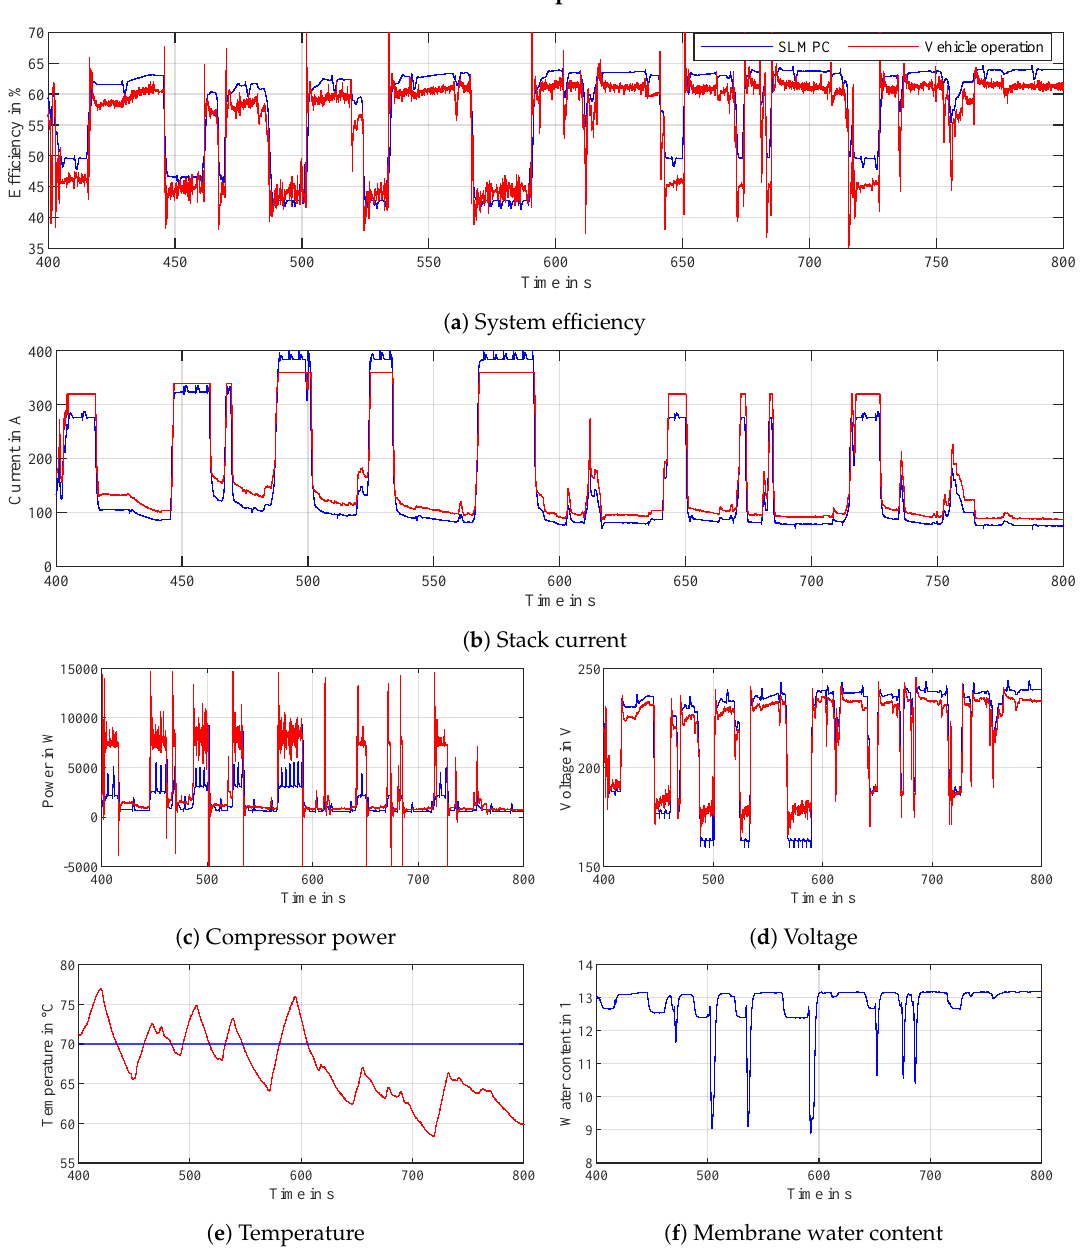
Figure 5. The blue line shows the SLMPC performance, whereas the red line shows the vehicle